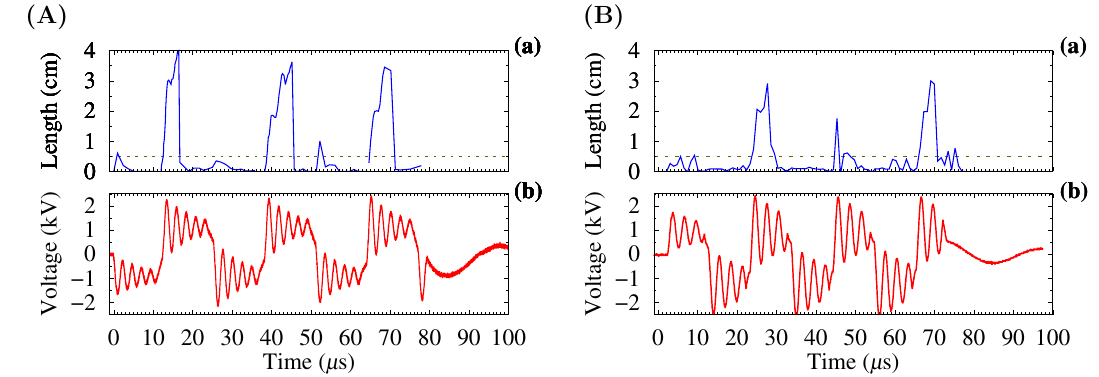
Figure 3. ( A ) APPJ length ( a ) and voltage signal ( b ) at the first negative pulse in the bunch with a duty cycle of ≈ 8 %. ( B ) APPJ length ( a ) and voltage signal ( b ) at the first positive pulse in the bunch. The horizontal dashed line shows the position of the tube orifice. The signals correspond to the images in Fig. 2.